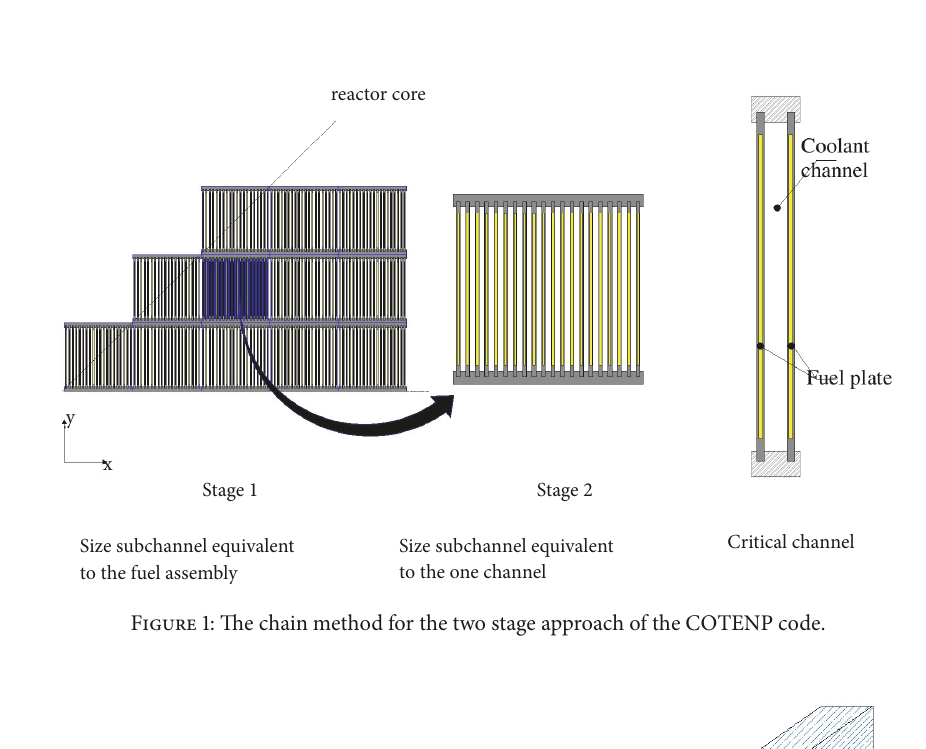
Figure 1: The chain method for the two stage approach of the COTENP code.